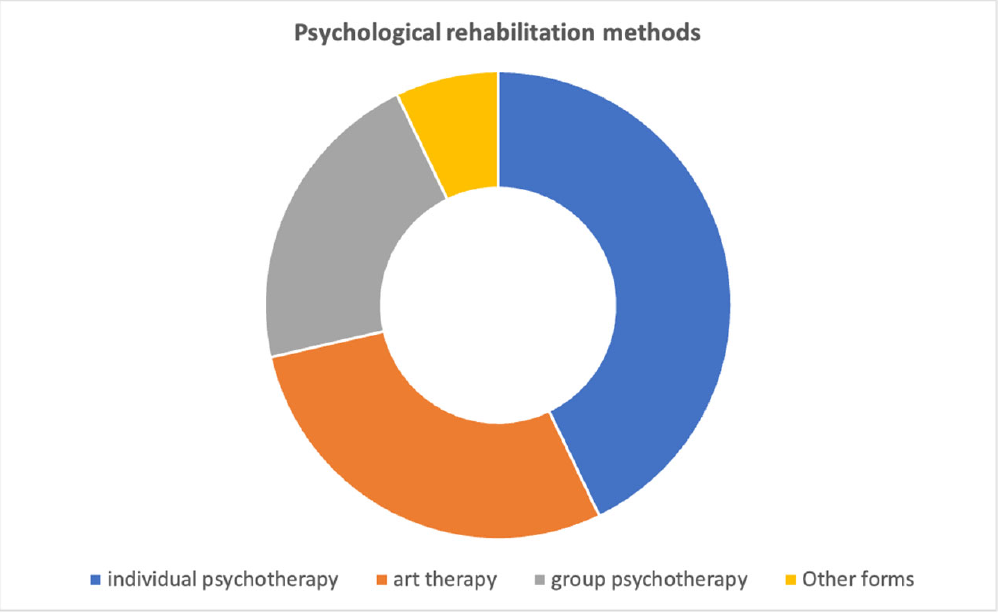
Figure 2. Evaluation of methods of post ‐ COVID rehabilitation.